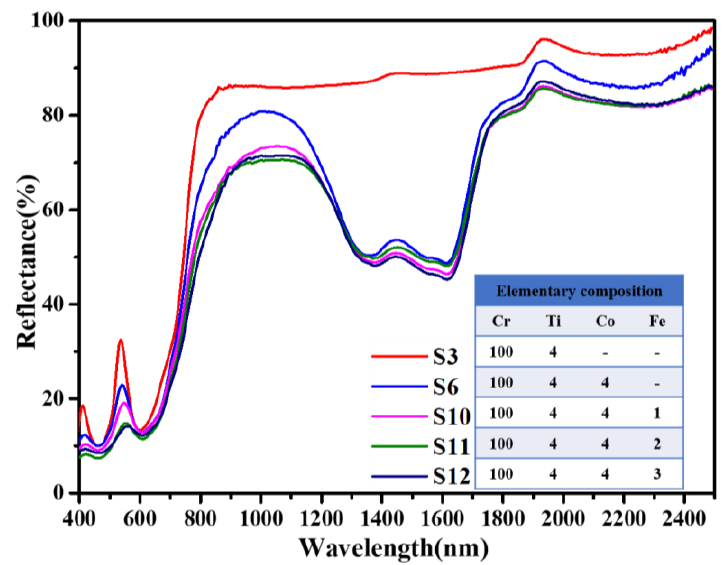
Figure 8. Diffuse reflectance spectra of Ti, Co, and Fe co-doped Cr 2 O 3 samples. Figure 8. Di ff use reflectance spectra of Ti, Co, and Fe co-doped Cr 2 O 3